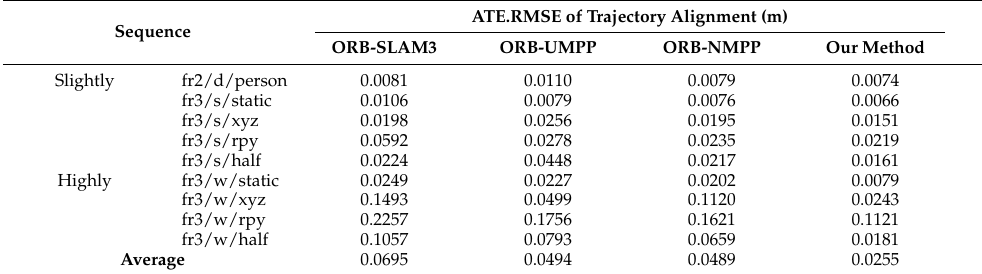
Table 7. The results of ablation